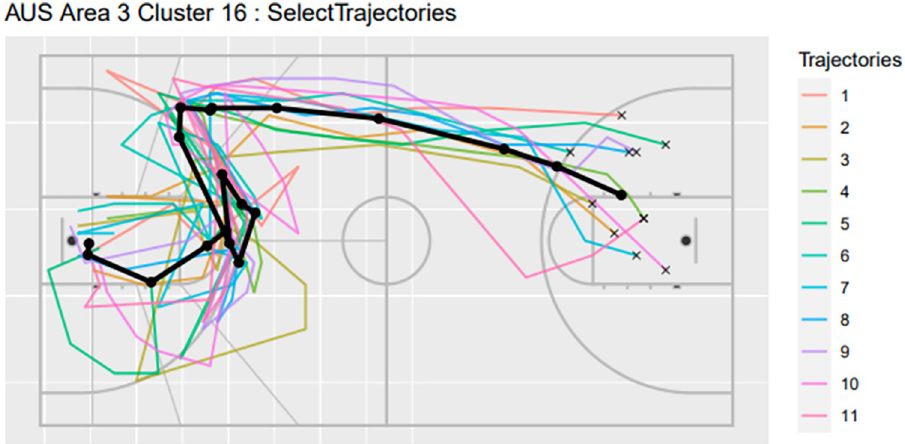
Fig 4. Trajectorial plots for Australia Area 3 Cluster